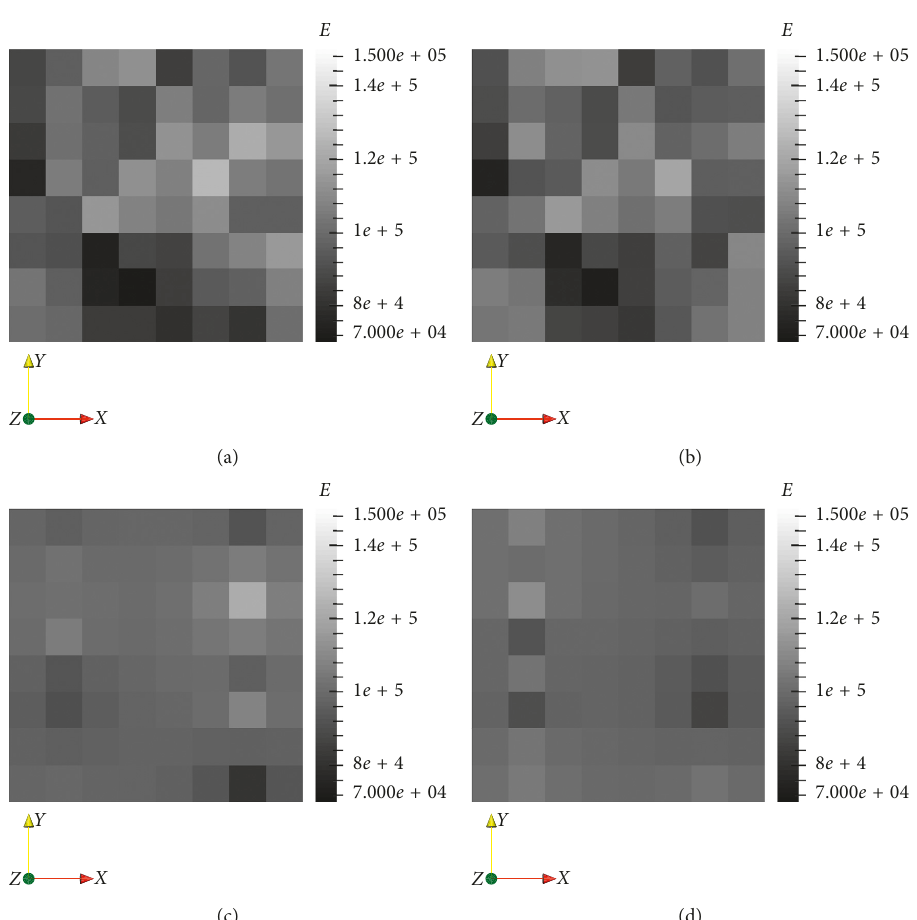
Figure 5: Example realisation j for unconditional field (a), conditional field (b), kriged field based on random field values at measurement locations (c), and kriged field based on measurement values (d), 2